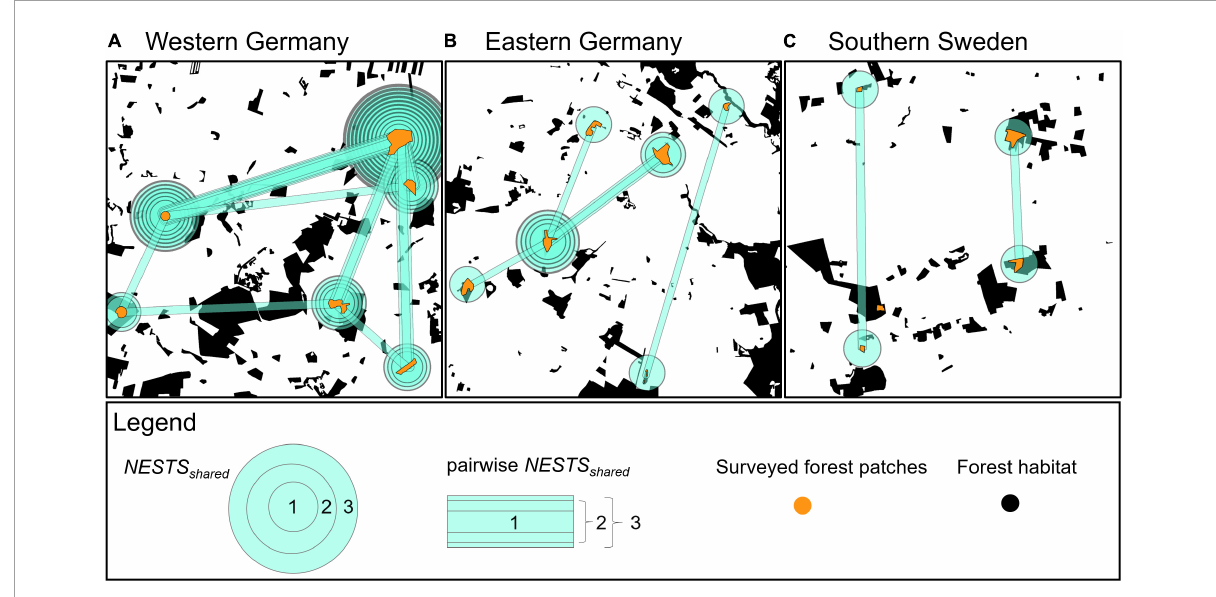
FIGURE2 Distribution of shared nests (nests with individuals in different forest patches) of B. pascuorum within and among forest patches in three 5 km × 5 km landscape windows (A–C) . The number of rectangles between two forest patches shows how many nests they shared. The number of circles show how many nests one forest patch shared with all other forest patches within the same landscape window.